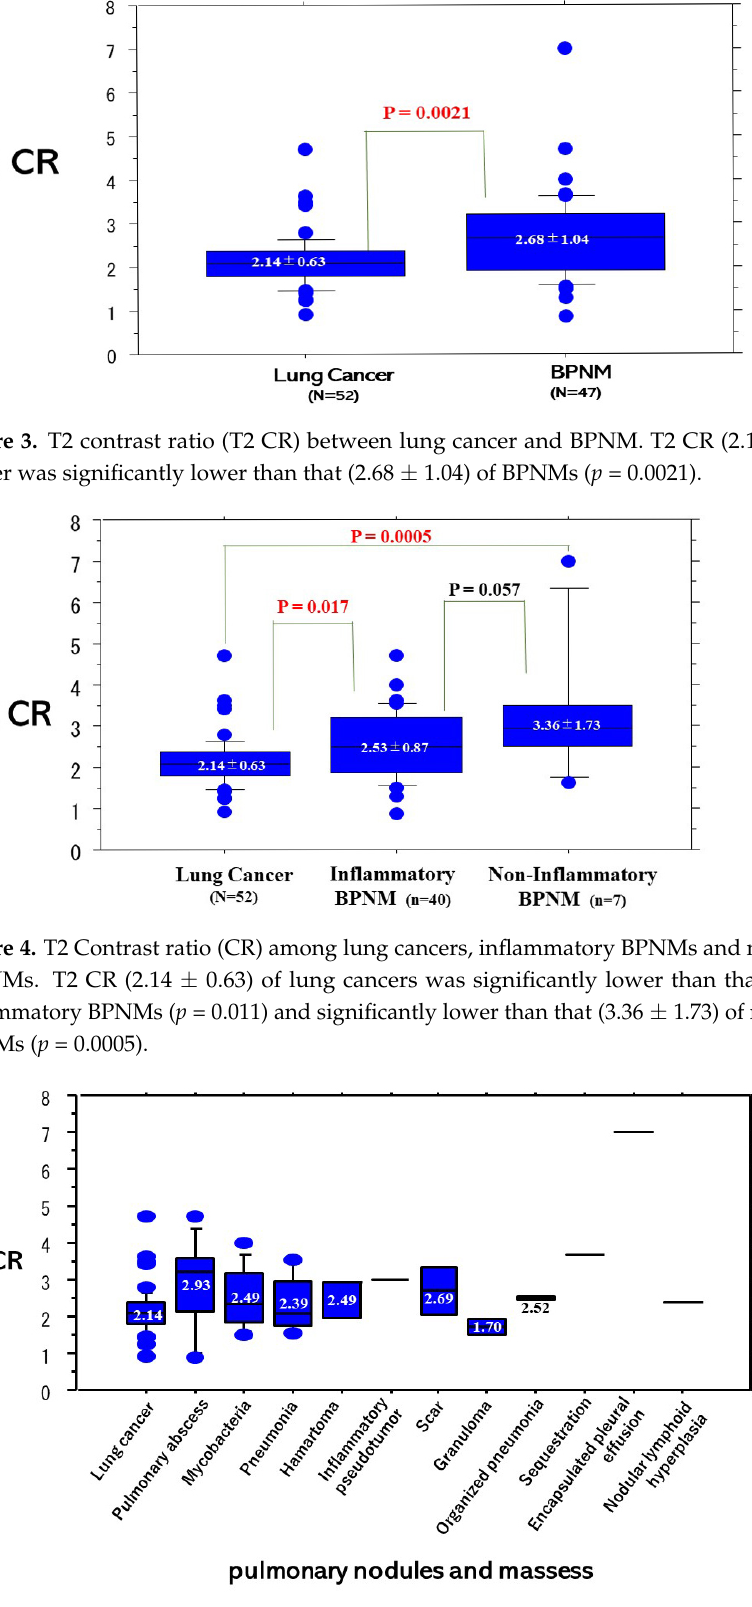
Figure 5. T2 WIs based on each diagnosis of PNMs. The T2 CR (2.14 ± 0.63) of lung cancer was significantly lower than that (2.93 ± 1.26) of pulmonary abscesses ( p = 0.0069) and not significantly lower than that (2.49 ± 0.80) of mycobacteria infections ( p = 0.11). For T2 CR based on pT factors and pN factors, there were not any significant differ- ences among pT factors or pN factors (Figure 6). For T2 CR based on pM factors and pStages, there were not any significant differences among pM factors or pStages (Figure 7). Figure 6. T2 CR based on pT factors and pN factors. There were no significant differences among T factors or N factors.